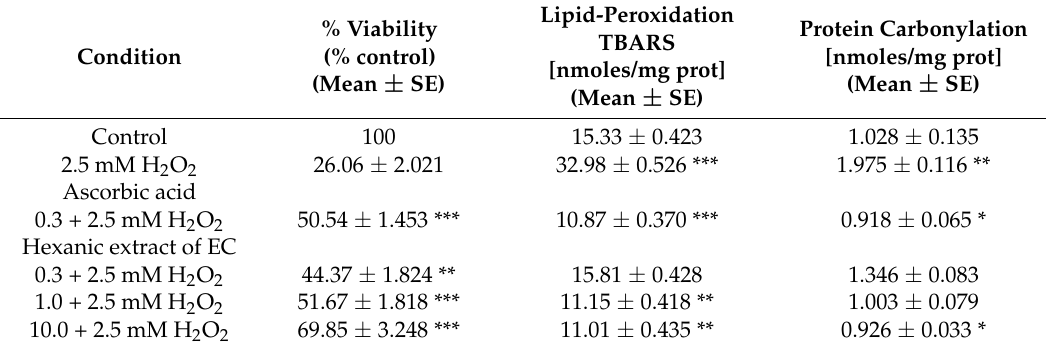
Table 3. Effects of the hexanic extract of E. carlinae on W303-1A yeast viability and oxidative modifications.